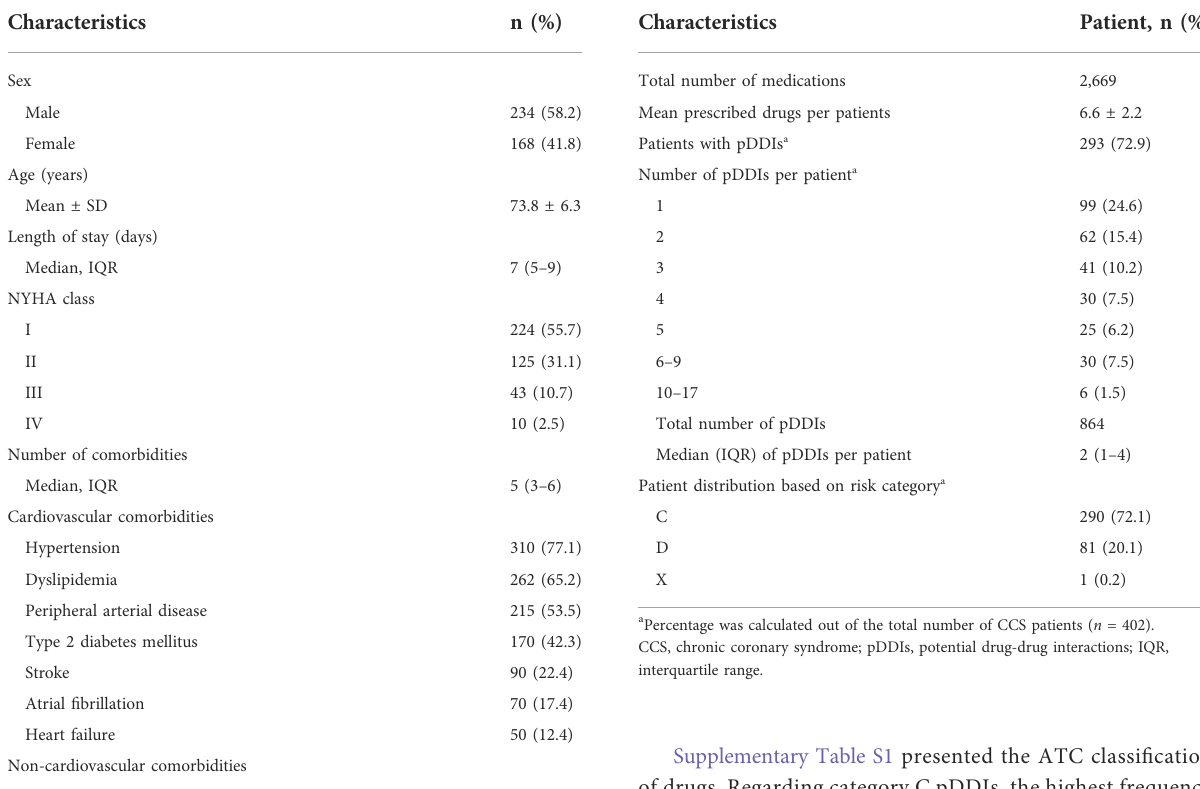
TABLE 2 Characteristics of the study sample (N = 402). TABLE 3 Prevalence of pDDIs among older CCS patients at